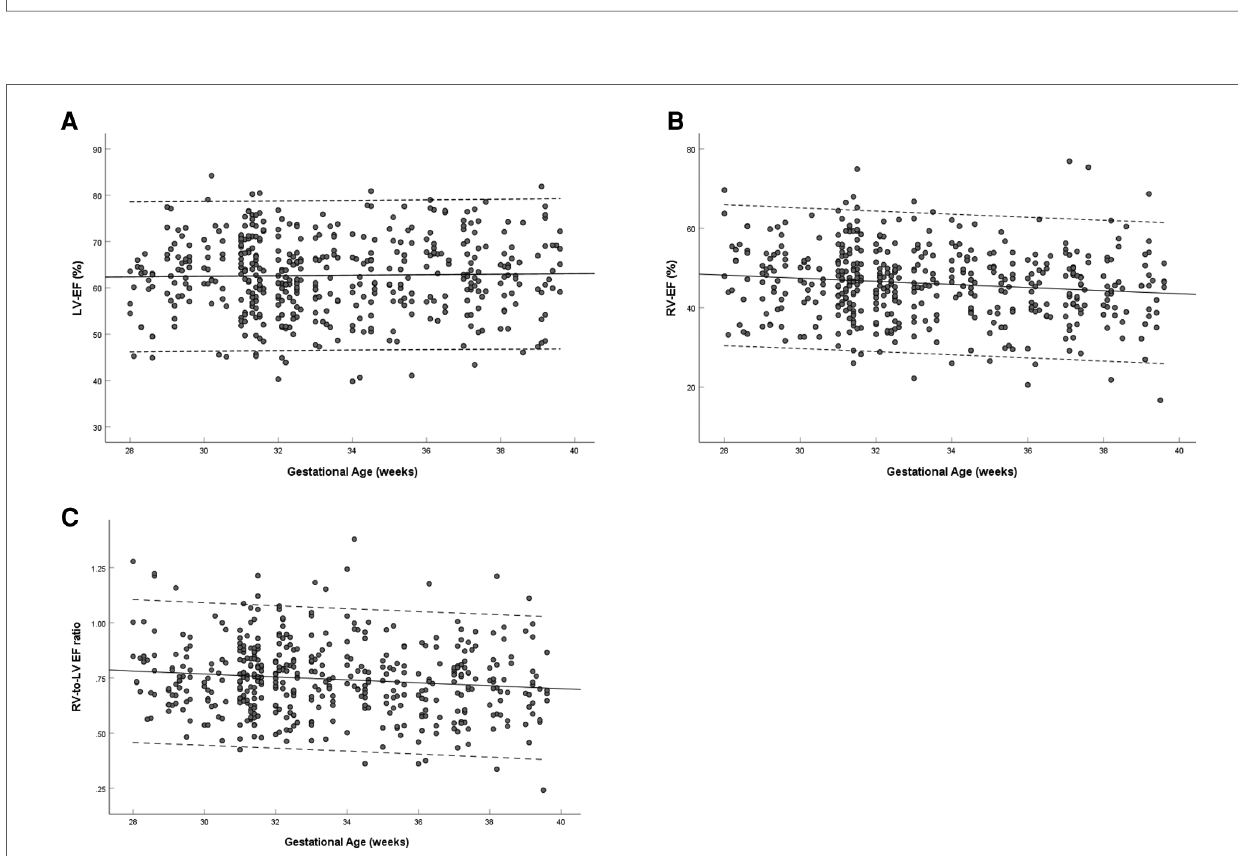
FIGURE 5 Scatterplots of left ventricular EF ( A ), right ventricular EF ( B ) and right-to-left ventricular EF ratio ( C ), according to gestational age (weeks), in 453 low-risk singleton pregnancies from 28 to 39 weeks gestation. Regression lines with the 5% and 95% con fi dence intervals are plotted with the regression equation. LV, left ventricle; RV, right ventricle; EF, ejection fraction.